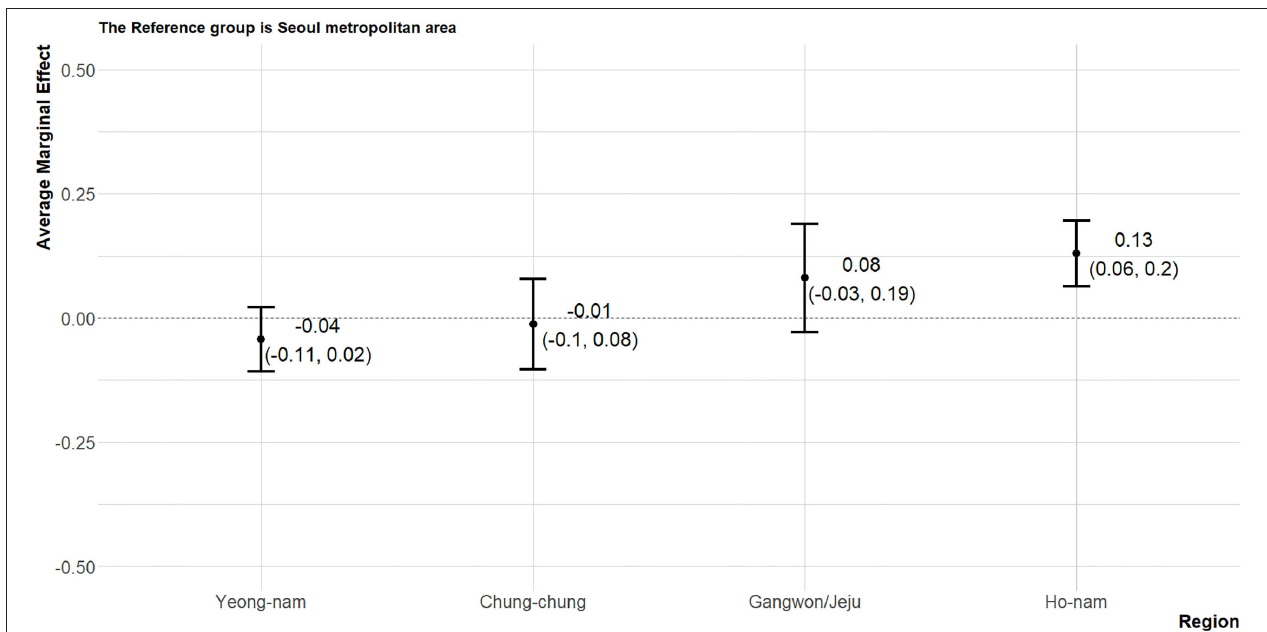
FIGURE 4 | The average marginal effects of residential area on attitude toward the cash transfer policy. The reference group is Seoul metropolitan